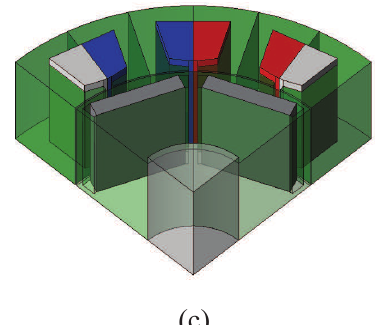
Figure 5. IPM 3D-FEM models: ( a ) V-shaped interior PMs ( w m = 15 mm); ( b ) V-shaped interior PMs ( w m = 30 mm); and ( c ) Straight interior PMs ( w m = 40 mm).